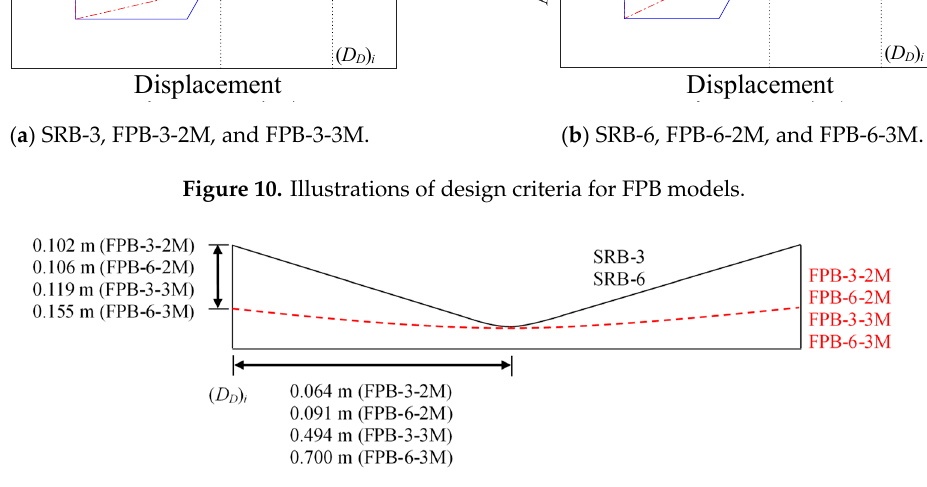
Figure 11. Illustrations of curved sliding and sloped rolling surfaces correspondingly designed for FPB and SRB models.